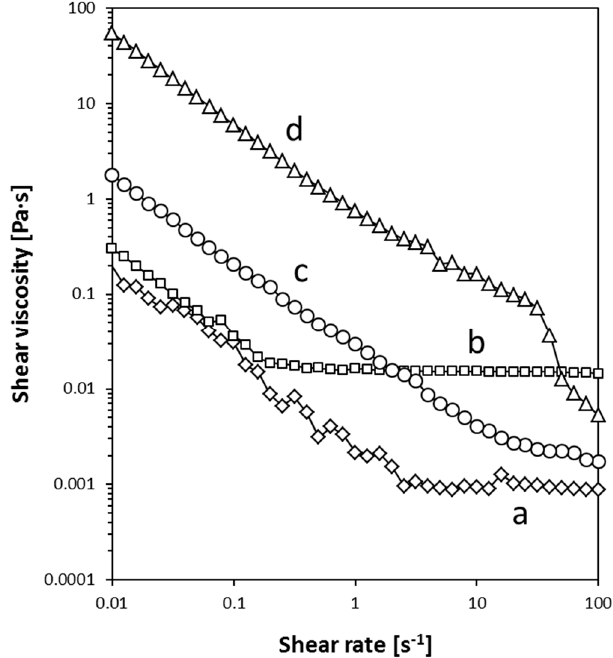
Figure 1. Rheological description of liquid products and dispersions: ( a ) SDBS solution; ( b ) Hycar ® 26084 acrylic resin; ( c ) MSH-2; and ( d ) MSH-0.